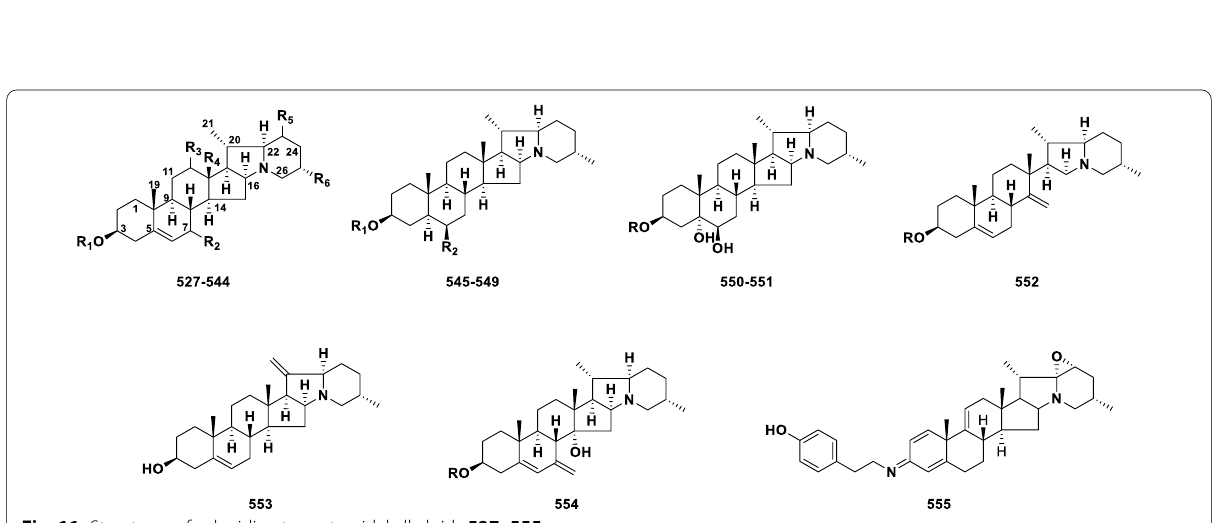
Fig. 11 Structures of solanidine type steroidal alkaloids